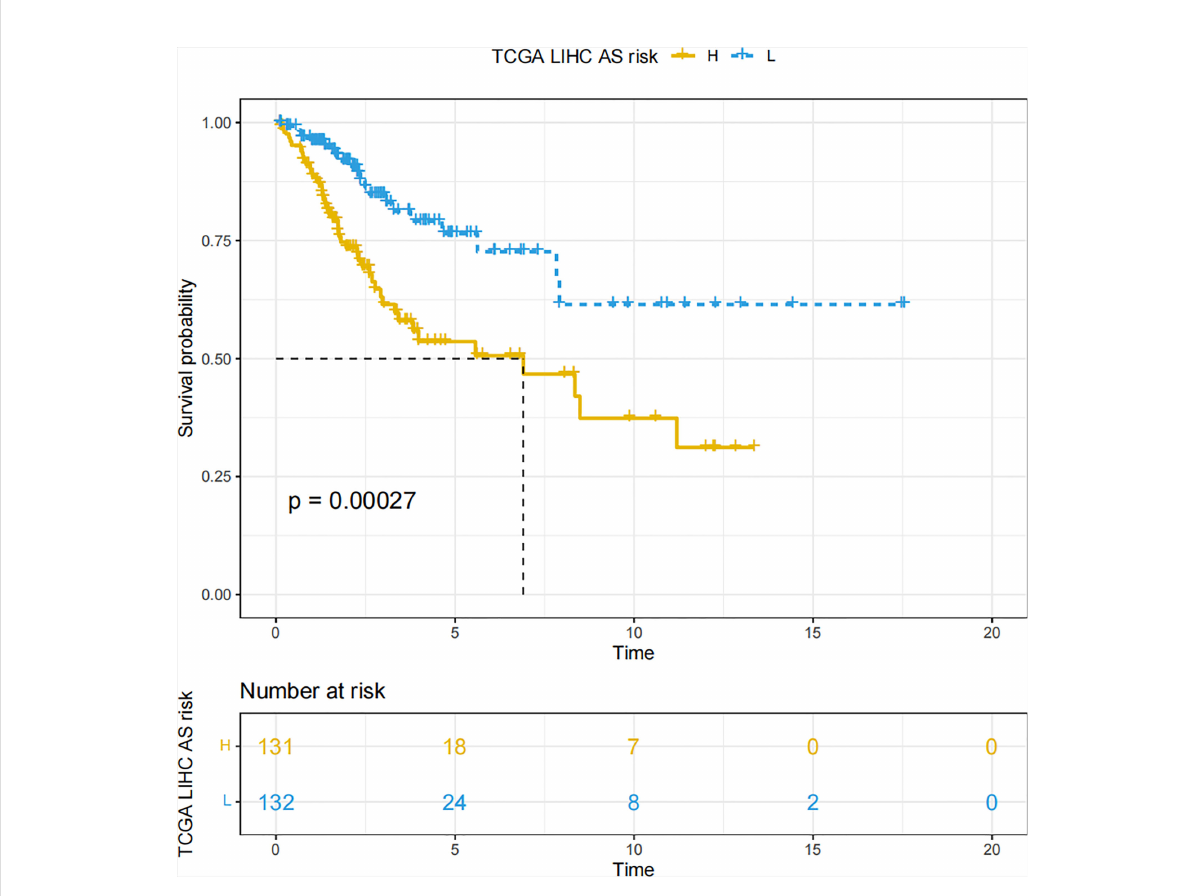
FIGURE 2 The Kaplan – Meier survival curves which are on account of the two NRLs ’ risk